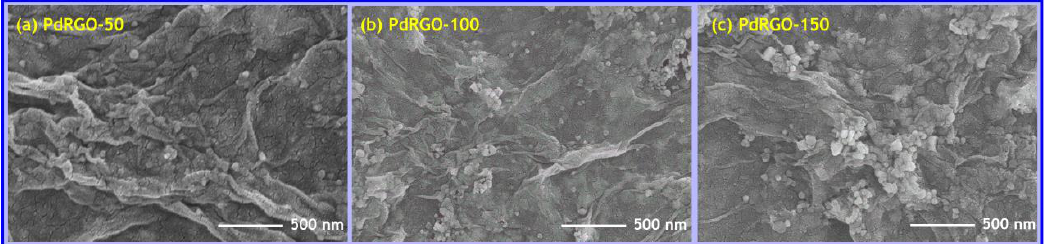
Figure 3. SEM micrographic images of green synthesized RGO-supported palladium nanoparticles with different concen- trations: ( a ) RGO-PN-50, ( b ) RGO-PN-100, and ( c ) RGO-PN-150.